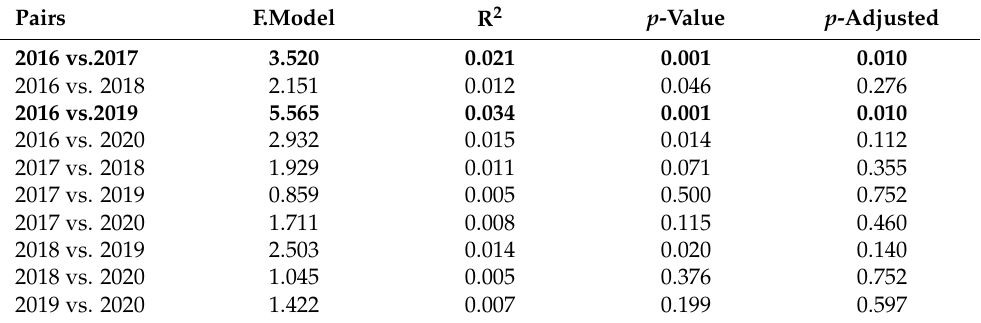
Table 2. Pairwise comparison with holm’s adjustment results for trophic level matrix across years. Significant values in